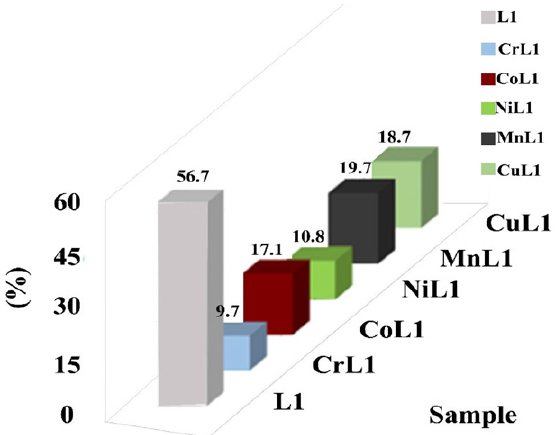
Fig. 6 . Graphical representation of Antioxidant Activities of MBHA (L1) and compounds 4-8